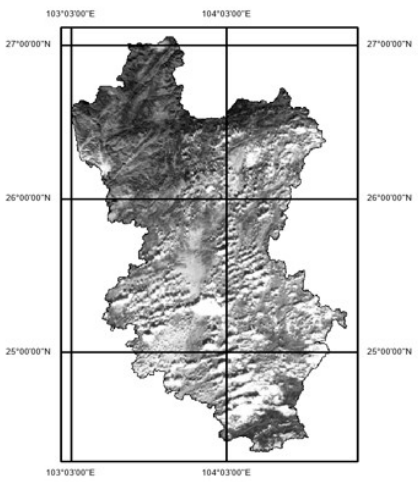
Figure 9. Qujing DISP mosaic results in the 1960s